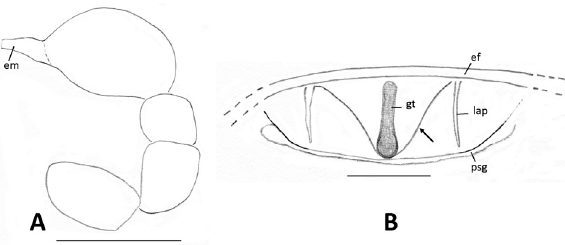
Figure 2. Cavisternum bom n. sp., from Mandaitivue FR: A , male left palp, retrolateral view; B , female epigastric region, dorsal view. Abbreviations: em , embolus; ef , epigastric furrow; lap , lateral apodemes; gt , genitalic tube; psg , posterior spiracu- lar groove. The arrow in ( B ) points to the thin semicircular rim in the epigastric area. Scale bars: 0.1 mm.